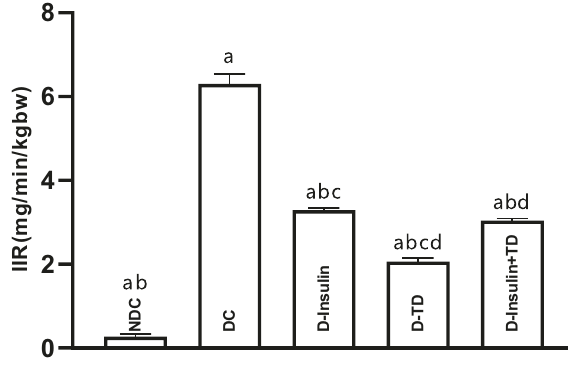
Fig. 4 Effect of TD on insulin sensitivity in male rats. Comparison of IIR in the non-diabetic control (NDC), diabetic control (DC), D- insulin, D-TD, and D-insulin + TD groups. DC group received 60 mg/ kg STZ. D-insulin group diabetic animals were treated with 2.5 U/kg insulin twice per day (1/3 morning and 2/3 in the evening), D-TD group diabetic animals were treated with daily IP injection of 40 mg/ kg thiamine disul fi de, D-insulin + TD group diabetic animals were treated with TD and insulin (2.5 U/kg insulin + 40 mg/kg TD once per day). Data are expressed as mean ± S.E.M ( N = 7). a Signi fi cant difference in IIR between the DC group and other groups (DC vs NDC ( p < 0.00001), DC vs D-insulin and D-insulin + TD ( p < 0.001), DC vs D-TD ( p < 0.0001). b Signi fi cant difference in IIR between the NDC group and other groups (NDC vs D-insulin and D-insulin + TD ( p < 0.01), NDC vs D-TD ( p < 0.001)). c Signi fi cant difference in IIR between the D-insulin group and the other two treatments (D- insulin vs D-TD groups ( p < 0.0001). d Signi fi cant difference in IIR between the D-TD and D-insulin + TD groups ( p <